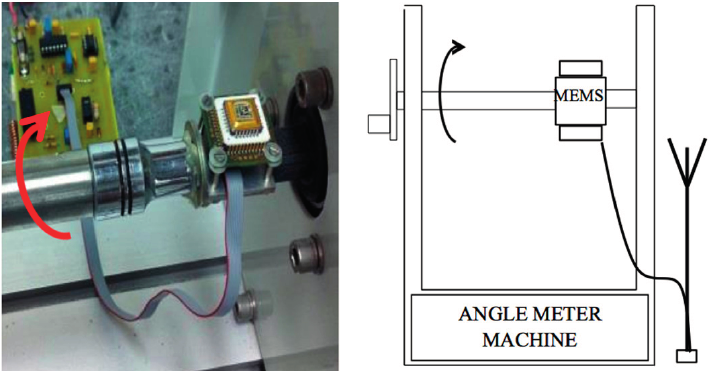
Figure 6. Setup for the static calibration test.